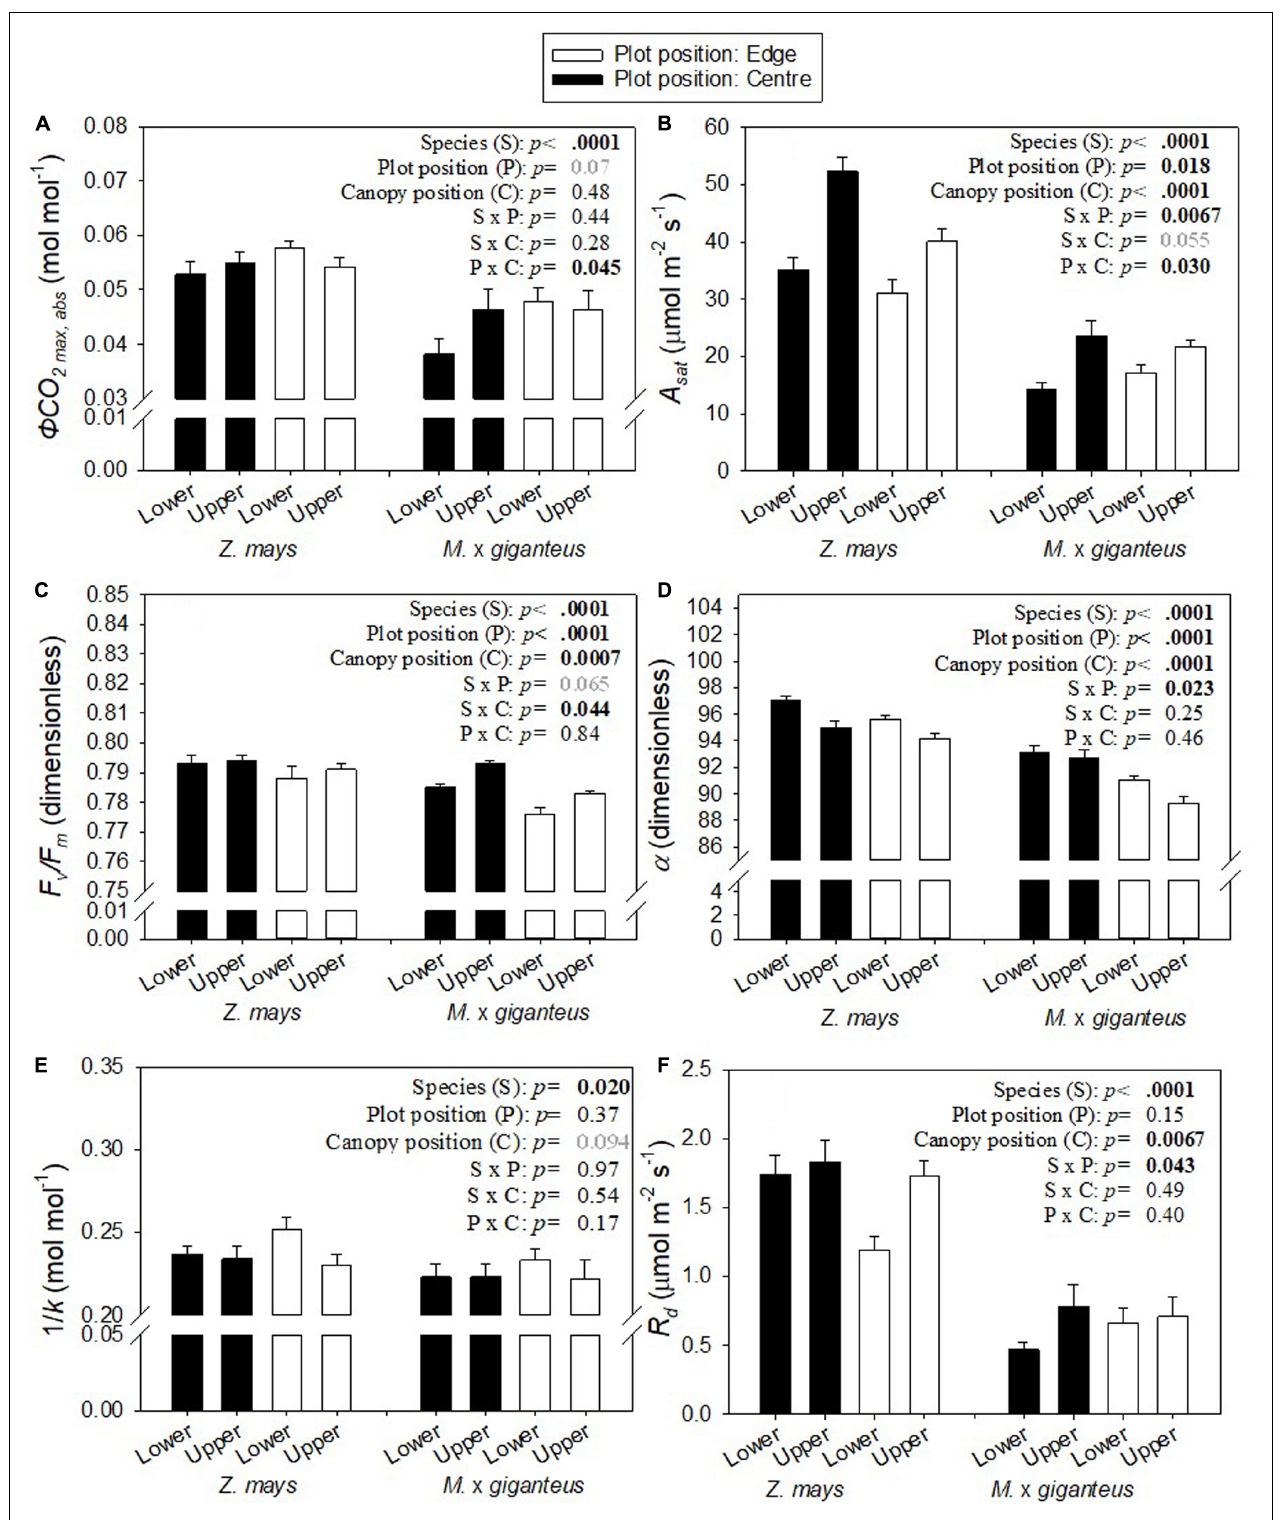
FIGURE 2 | Mean ± s.e. for (A) φ CO 2 max , abs , (B) A sat , (C) F v /F m , (D) α , (E) 1/ k , and (F) R d for Z. mays and M. x giganteus for upper and lower canopy leaves in both plot positions (centre, edge) ( n = 8–16). p -values are from ANOVA testing the fixed effects of species, plot position, canopy position, and all two-way interactions. Significant p-values ( < 0.05) are in bold black. Marginally significant p -values ( < 0.1) are in bold grey.